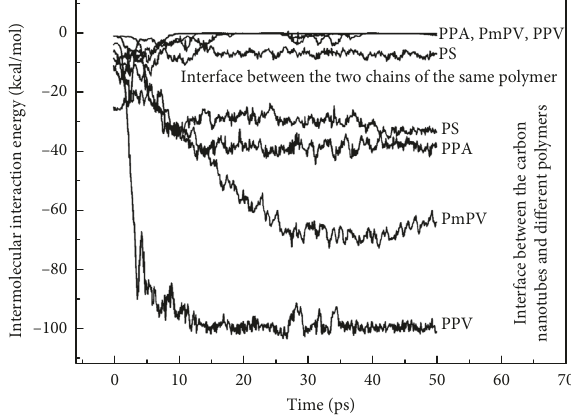
Figure 10: Time evolution of the intermolecular interaction energy at the interface between single-walled carbon nanotubes and dif- ferent polymer matrices as well as between the two chains of the same polymer during the wrapping procedure for polystyrene (PS), poly( p -phenylenevinylene) (PPV), poly( m -phenylenevinylene-co- 2,5-dioctyloxy- p -phenylenevinylene) (PmPV), and poly(phenylacetylene) (PPA) (adapted with permission from reference [187]; copyright 2005, American Chemical Society).